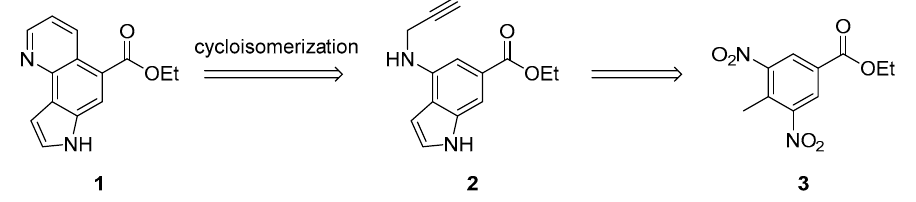
Figure 2. Retrosynthetic analysis of aaptoline B ( 1 ).